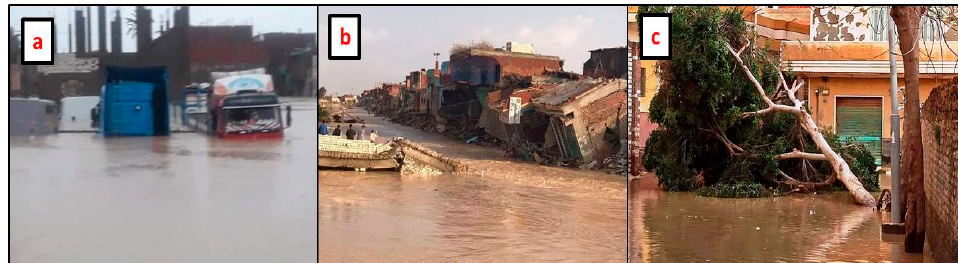
Figure 10. Field photographs showing the destructive impacts along the intersection of the outlet of the Wadi Al Rishrash catchment at the Al Dismi village after the flood event of 13 March 2020, including damage of vehicles ( a ) drowning of urban centres ( b ), and damage of trees ( c ). The location of the Al Dismi village is highlighted in Figure 1.